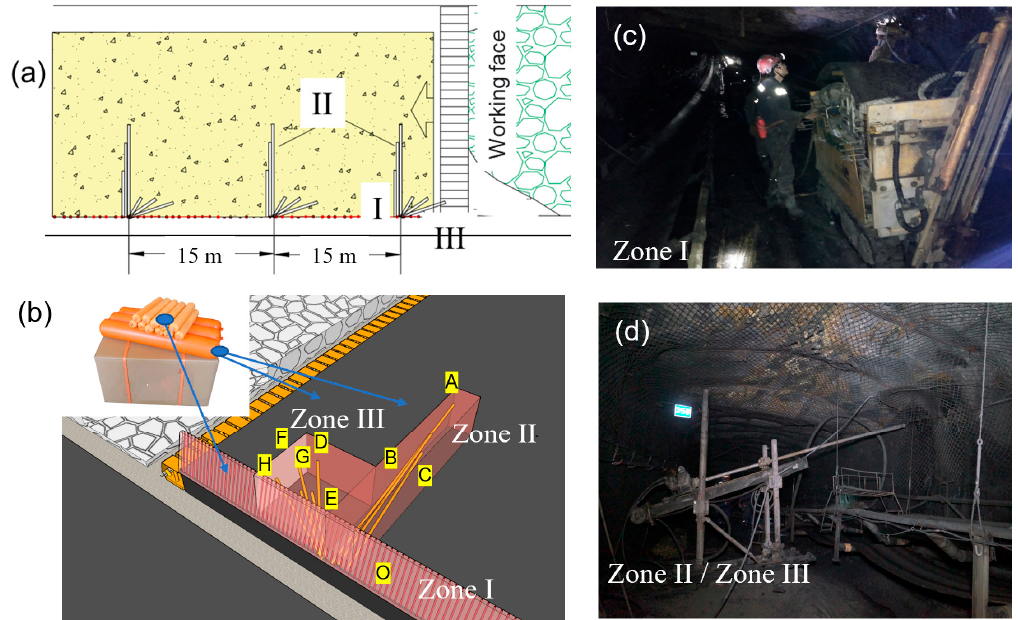
Figure 8. Three-Zone pre-split design parameter and site construction ( a ) Plan view of the blasting design ( b ) 3-D Sketch view of the blasting design ( c ) Roof cutting Blasting construction (Zone I) ( d ) Deep hole blasting (Zone II/Zone III)